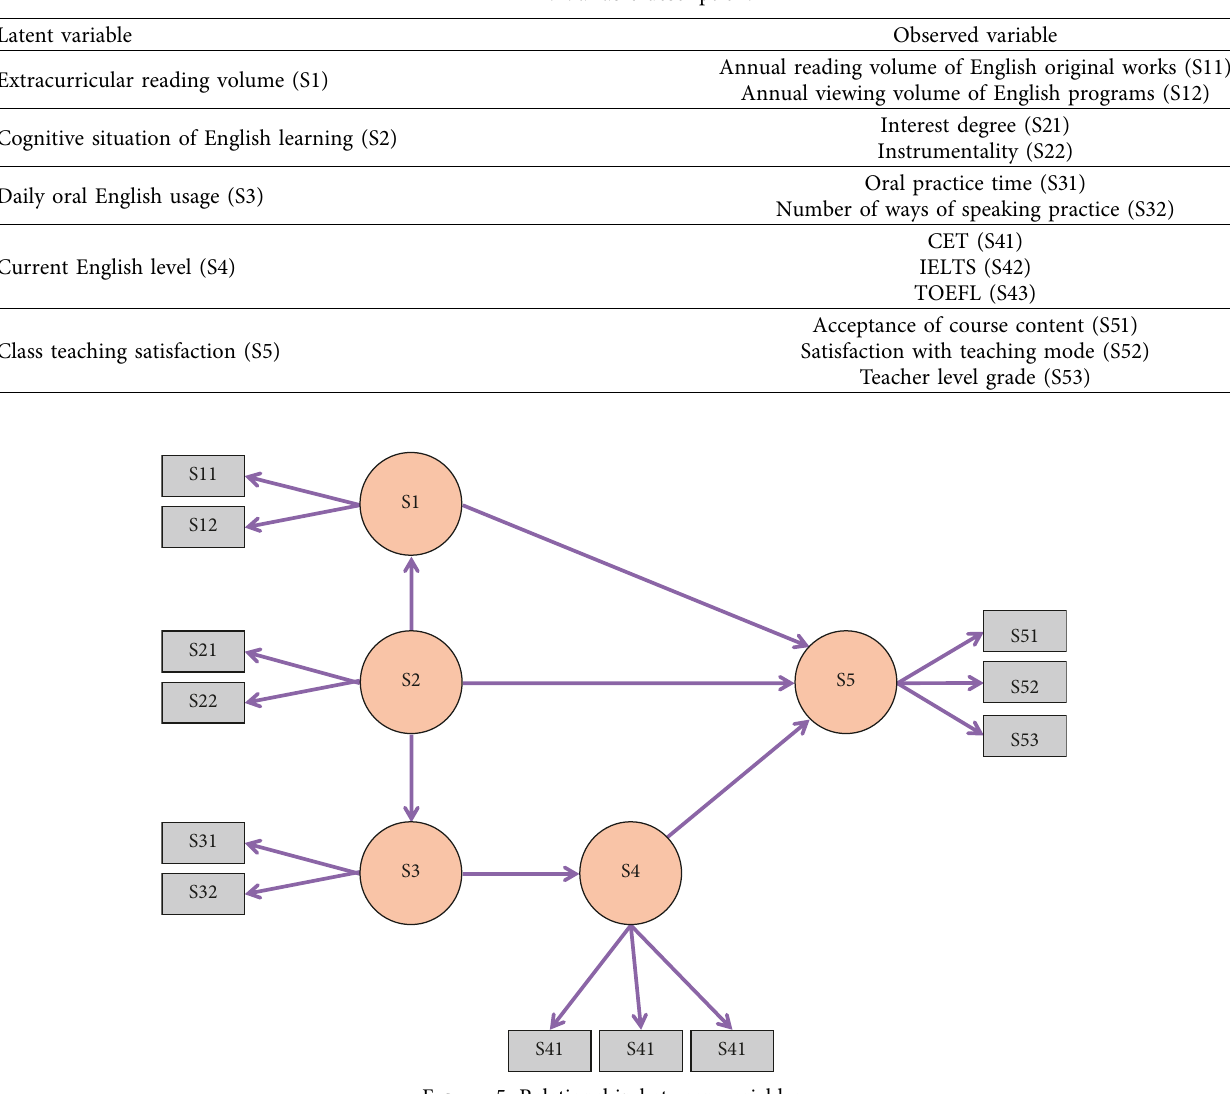
Table 1: Variable description.